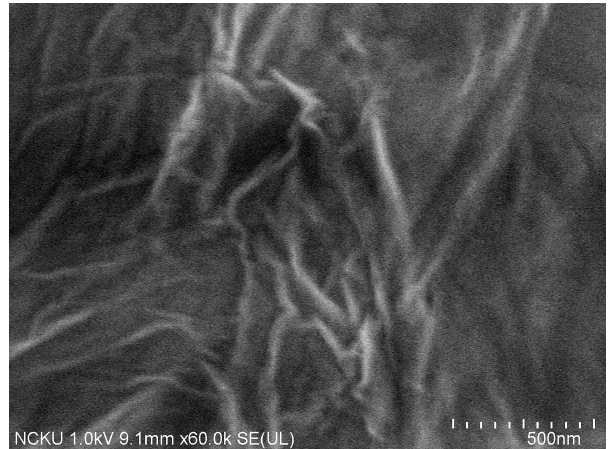
Figure 5. SEM image of synthesized graphene oxide.